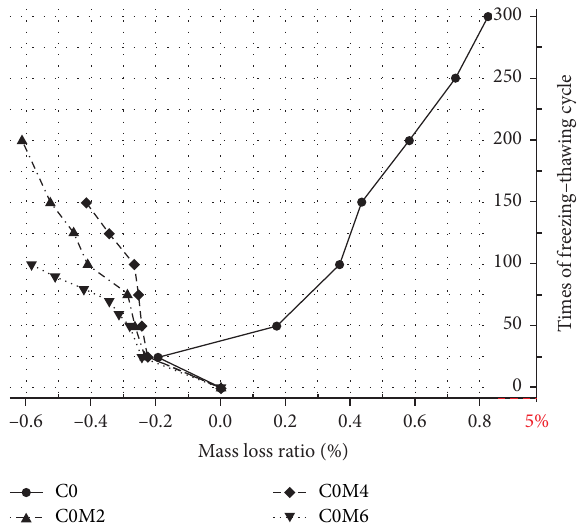
Figure 3: Variation law of relative dynamic elastic modulus ( P with freeze-thaw cycle times.